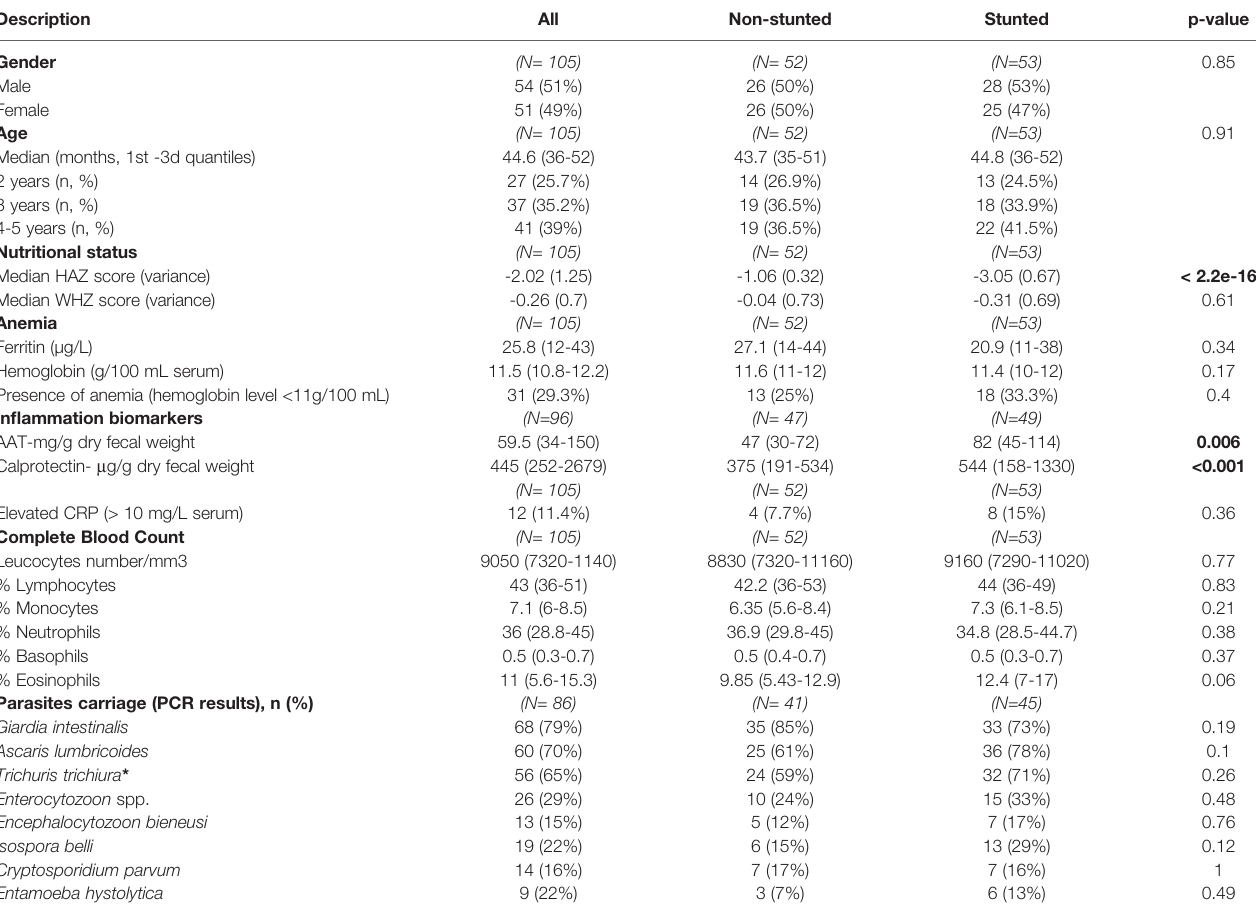
Table S4 , b = 0.21, p = 0.03). In the model predicting the